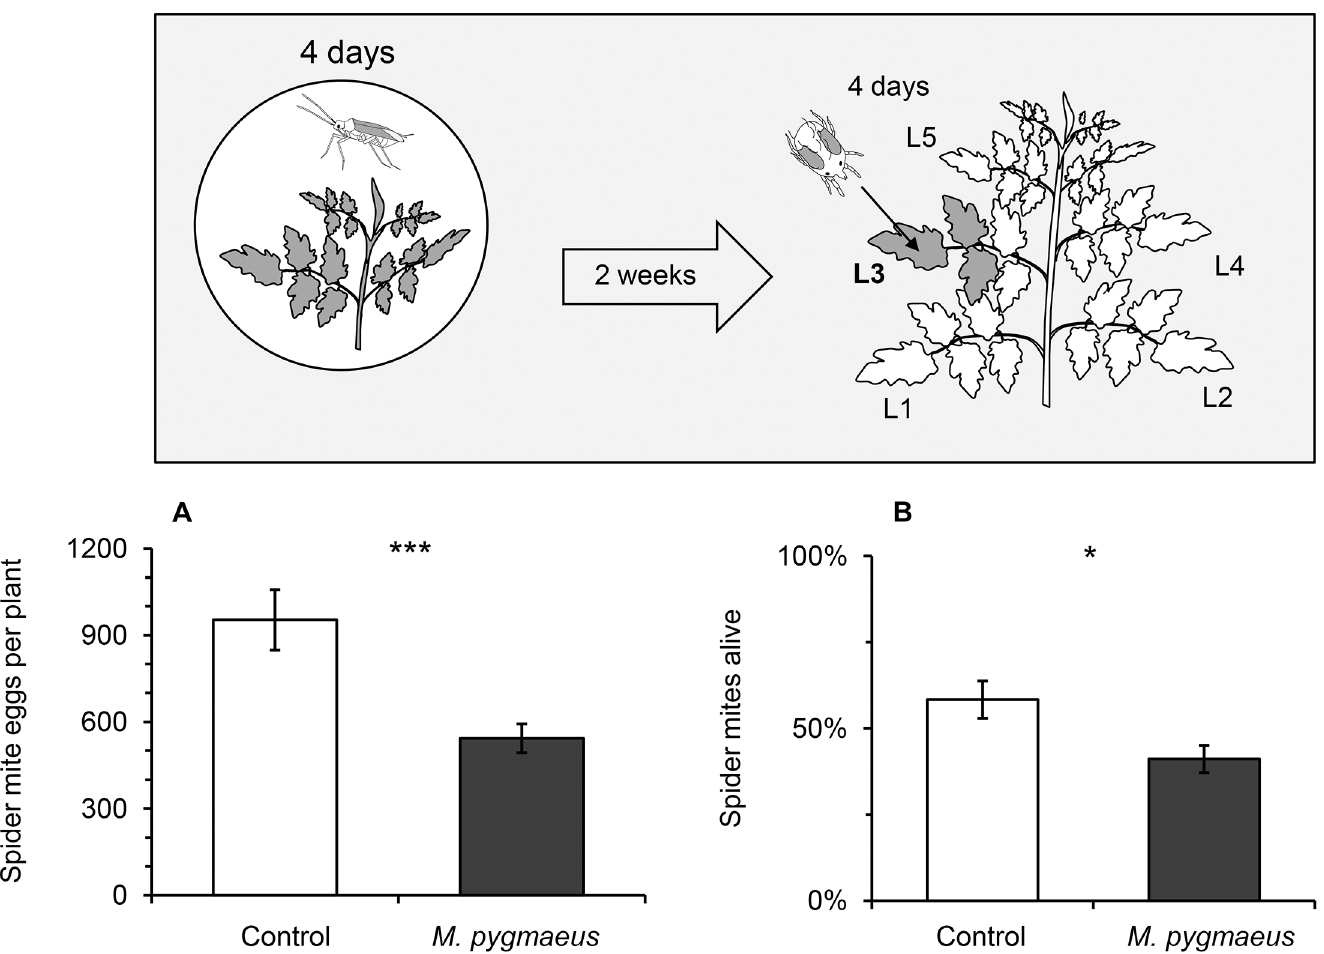
Fig 5. Persistence of plant-mediated effects of Macrolophus pygmaeus on the performance of Tetranychus urticae . (A) Number of eggs per plant and (B) survival of females of T . urticae (mean +/- SE of 8 plants) 2 weeks after exposure of young plants to 2 M . pygmaeus females for 4 days (dark bars, setup is depicted in inset) or the corresponding control plants (white bars). Significant differences between exposed plants and control plants are indicated by asterisks following a GLMM: P < 0.05 ( * ), P < 0.001 ( *** ).